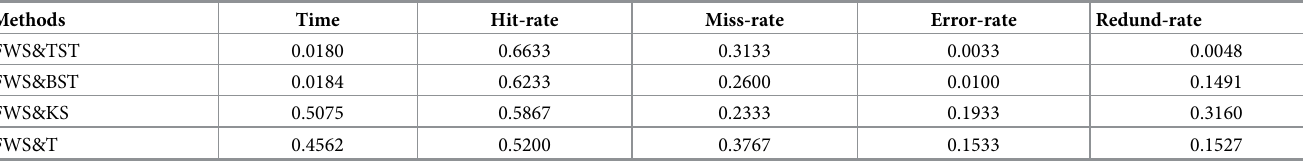
Table 2. The mean analyses on MCPs detection under different sizes of Nw from 2^6 to 2^15 in the FWS framework. Methods